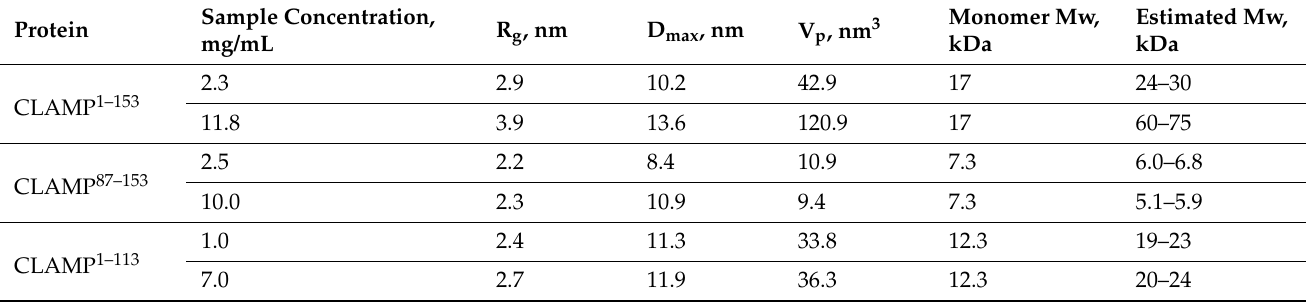
Table 1. Scattering parameters of CLAMP N-terminal domain derivatives. R g , radius of gyration (average of square center-of-mass distances in the molecule); D max , maximum dimension of the particles; V p , Porod volume (excluded volume of hydrated